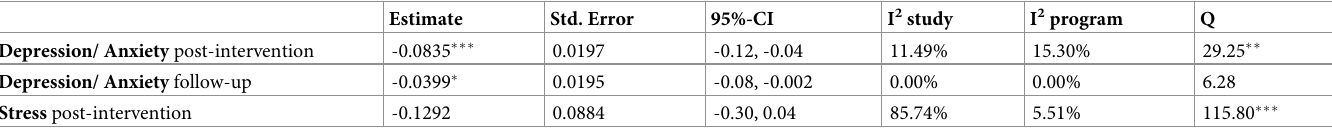
Table 4. Multilevel meta-analysis